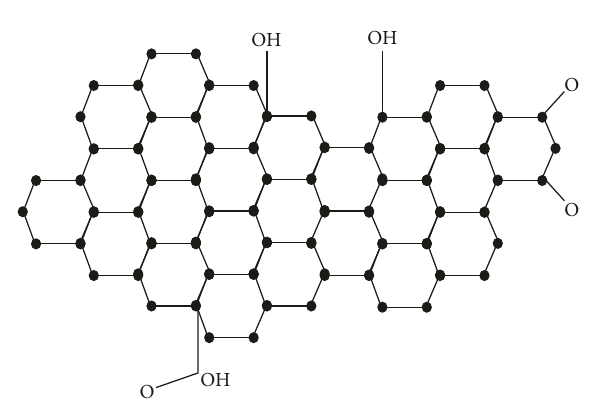
Figure 4: Graphene oxide